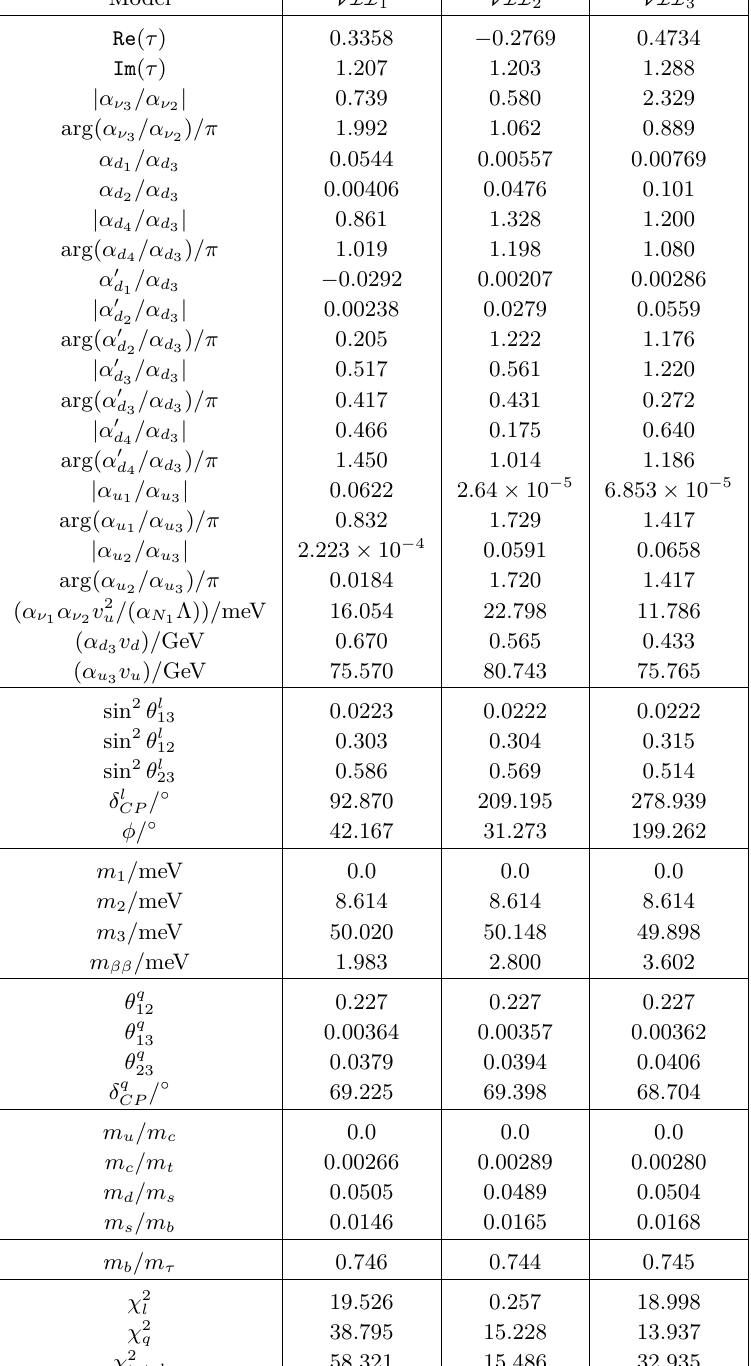
Table 15 . The best fit values of the free parameters and the corresponding predictions for lepton and quark mixing parameters and fermion masses for the phenomenologically viable models of